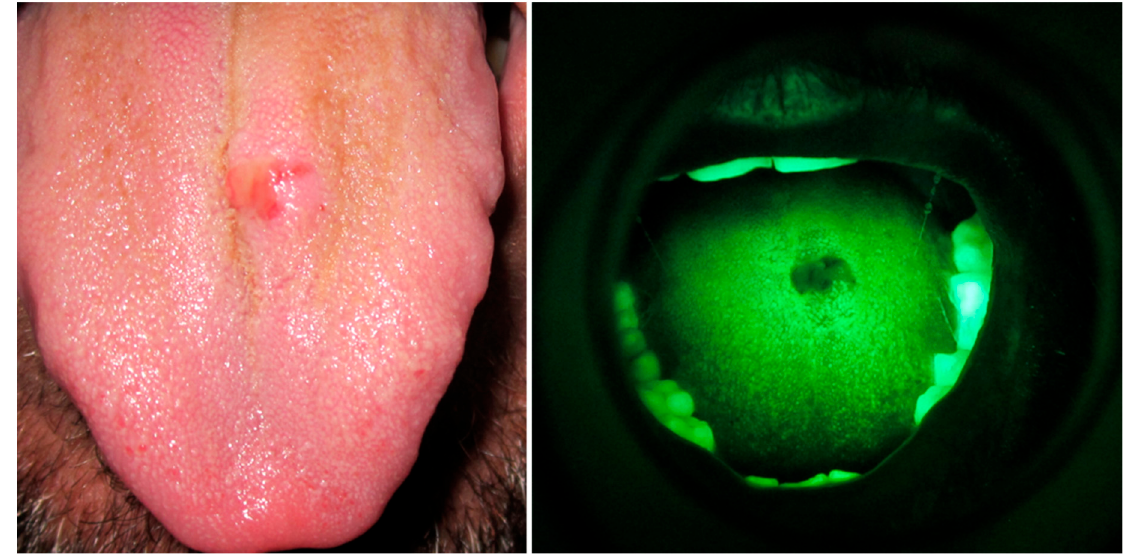
Figure 1. VELscope ® results before a tongue biopsy. COE vs. VELscope ® . For gentle concession of Prof. L. Laino.